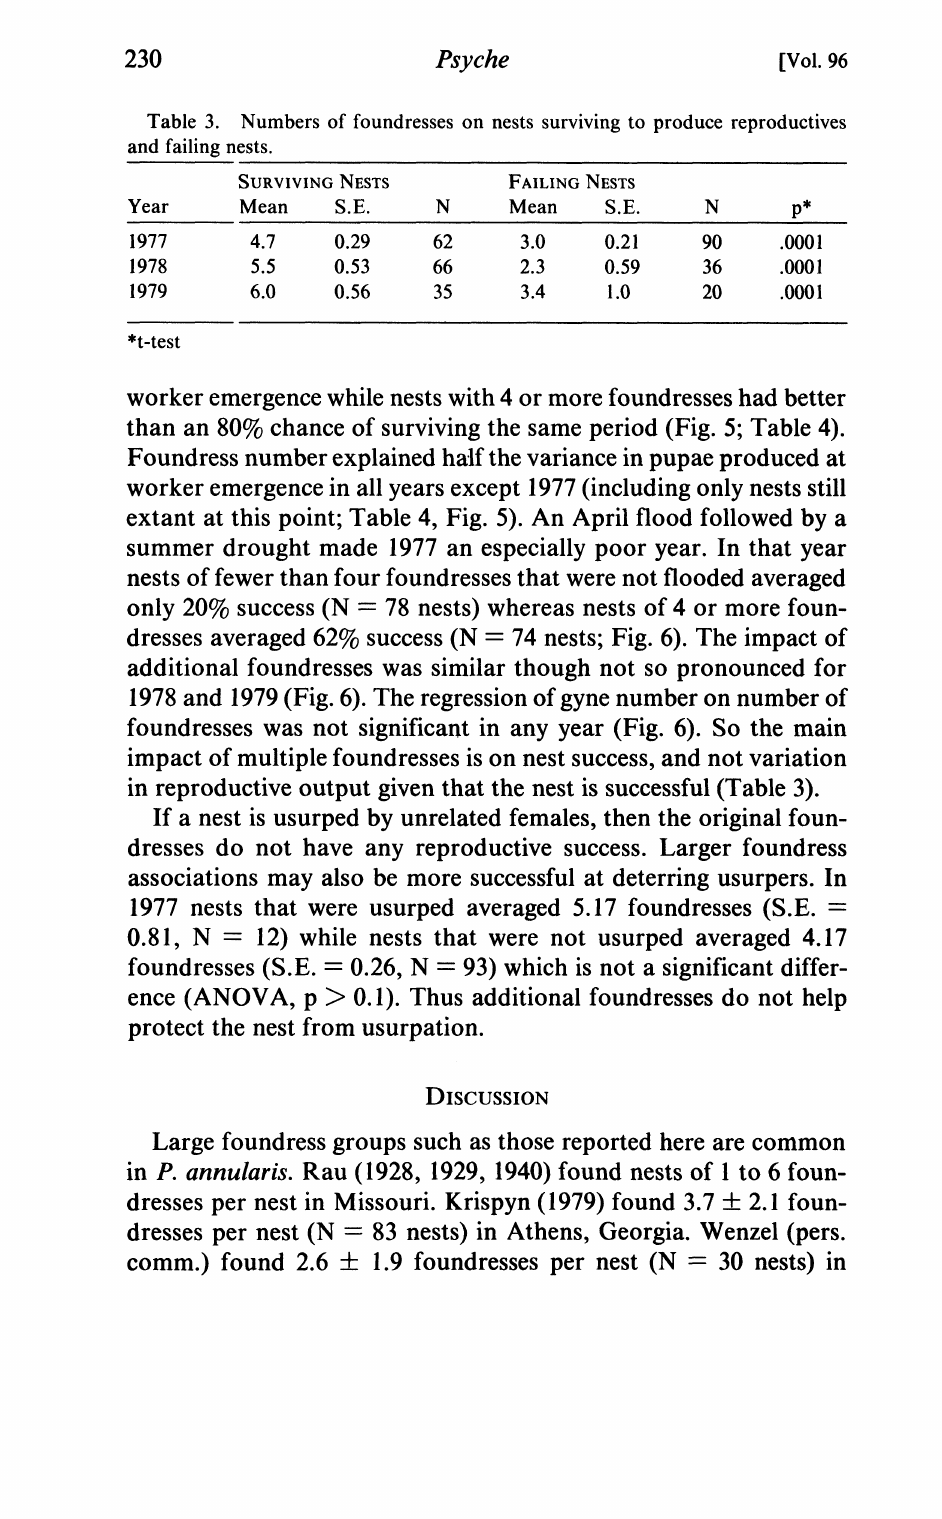
Table 3. Numbers of foundresses on nests surviving to produce reproductives and failing